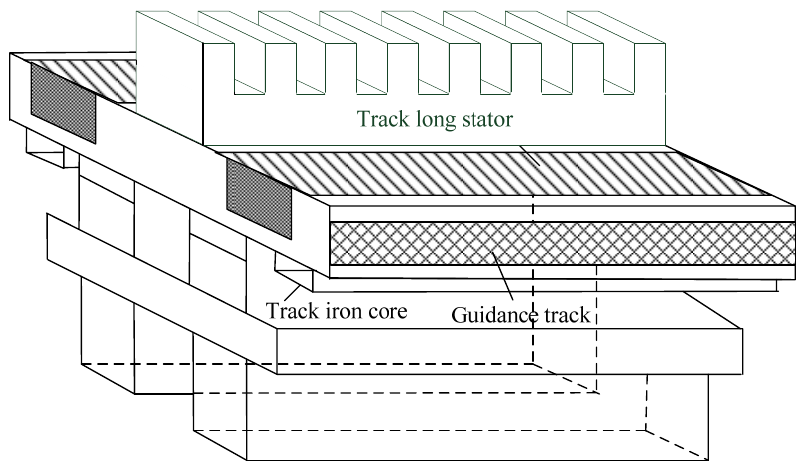
Figure 1. The long stator and track